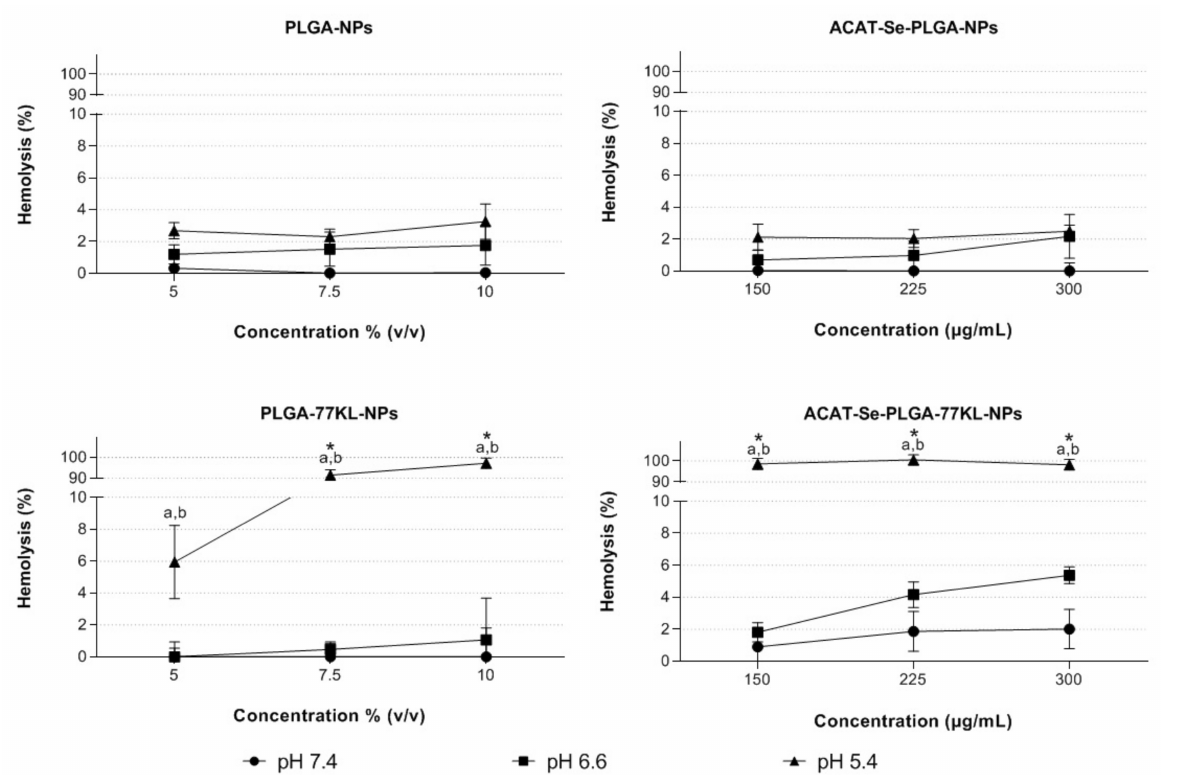
Figure 4. pH-dependent membrane-lytic activity of NPs after 5 h of incubation with human ery- throcytes at different pH values. Each value represents mean ± SE of three experiments. Statistical analyses were performed using ANOVA followed by Student–Newman–Keuls multiple comparison test. a Significantly different from pH 7.4 ( p < 0.05) and b from pH 6.6 ( p < 0.05). Asterisk indicates significant difference between NPs with and without 77KL ( p < 0.05).